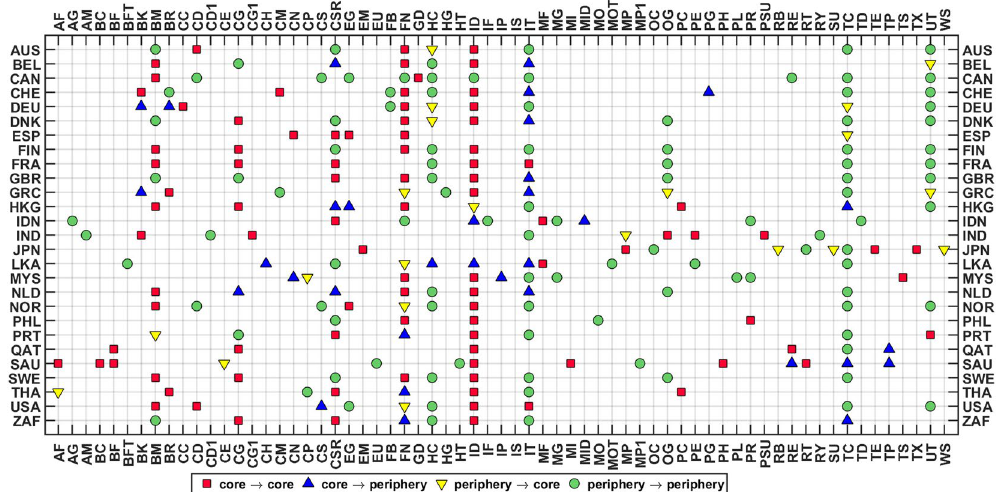
Figure 3. Sectoral dynamics and core-periphery structure: Chart of the 65 sectors (horizontal axis) in the 27 countries (vertical axis), showing the evolution of the core-periphery structure over two snapshots, 2008–09 and 2015–16. Interpretation: x → y implies x in 2008–09 became y in 2015–16 ( x , y ∈ { core , periphery }). Visual inspection reveals that Finance (FN) and Industries (ID) sectors are frequently occurring in the core across almost all countries. Sectoral abbreviations given in the Table 1 in Materials and Methods. Also, countries like Canada (CAN), Finland (FIN), France (FRA), Philippines (PHL) and Sweden (SWE) maintain a stable core- periphery structure with no change, whereas the rest of the countries show different degrees of change in the core-periphery